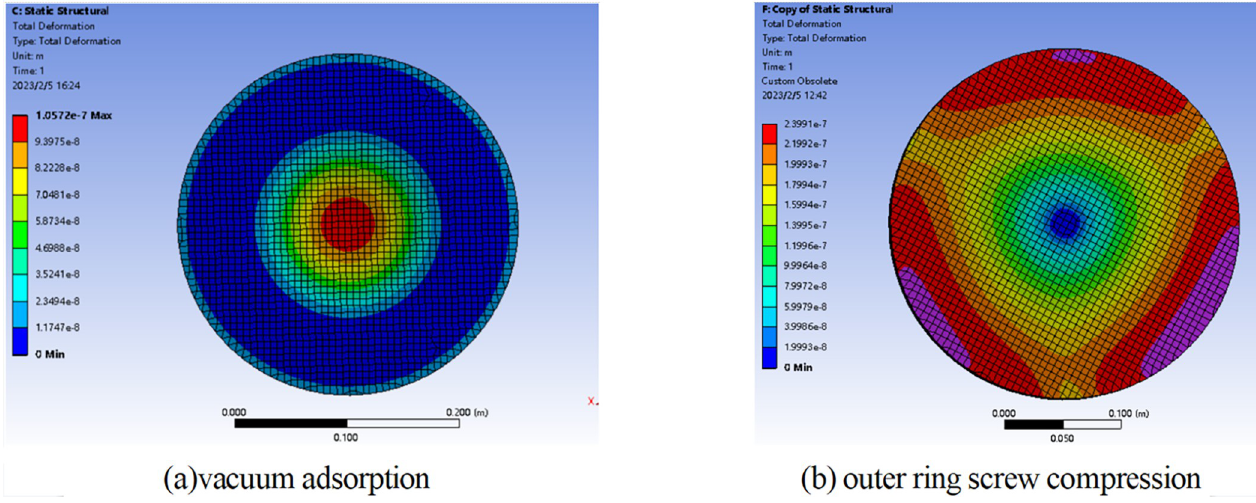
Fig 1. Error distribution of centrifugal force deformation caused by different clamping methods.